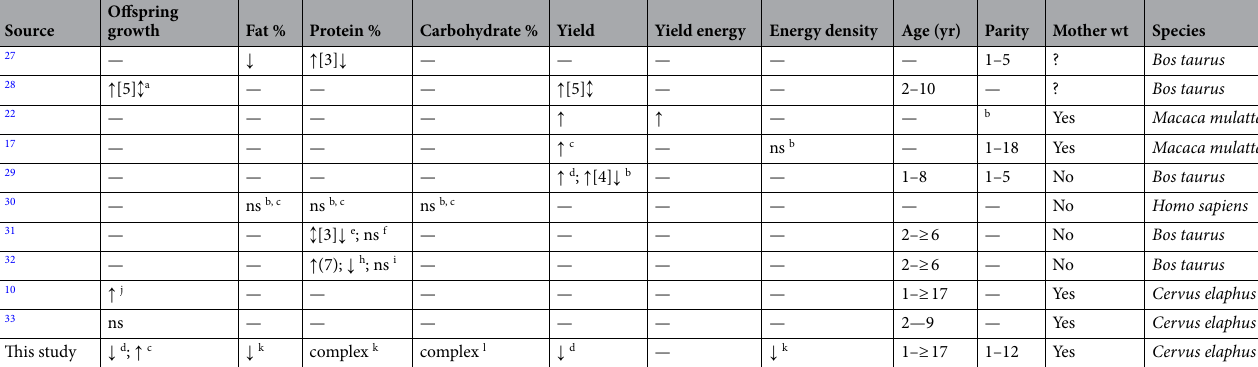
Table 2. Response of offspring growth and milk traits to mother age in published studies. a Offspring weight at age 205 d; b Primiparous vs. multiparous; c Response to parity; d Response to age; e Significant for total protein and casein; f Non-significant for serum protein; g Inmunoglobulin; h β-lactoglobulin or α-lactalbumin; i Non- significant for bovine serum albumin; i Growth rate; k Interaction mother age × lactation day; l Interaction mother age × lactation day × offspring sex. Type of response: decreasing ( ↓ ), increasing ( ↑ ), plateau ( ↕ ). The age (and/or parity value) at which the response reaches a maximum or plateau is displayed in square brackets. Complex responses are depicted by a combination of arrows and number of years in brackets, for example, ↑ [5] ↕ represents an increase with age plateauing at 5 years. Non-significant